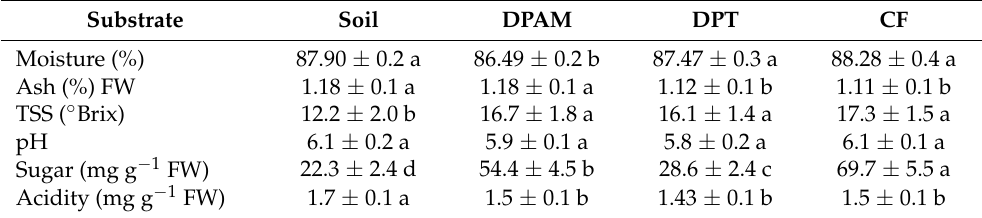
Table 4. Physico-chemical parameters of melon fruit. Plants were grown on different substrates. DPAM: compost of date palm residues and animal manure; DPT: compost of date palm